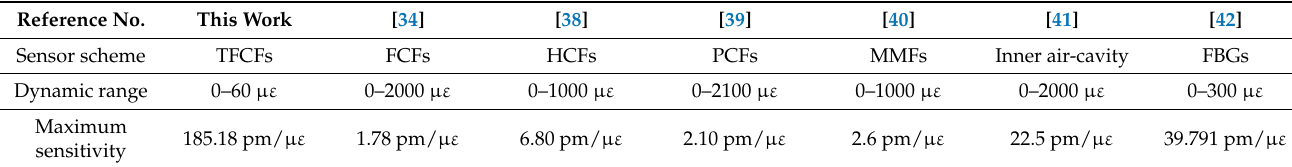
Figure 3. Spectral responses of the TFCF interferometer under different tensile strain for ( a ) D = 15 µ m, ( c ) D = 7.5 µ m, and ( e ) D = 3 µ m, respectively. Linear fitting curves of the dip wave- length shifts and the coefficients of determination R 2 of linear fitting for ( b ) D = 15 µ m, ( d ) D = 7.5 µ m, and ( f ) D = 3 µ m, respectively. Table 1. Summary of strain sensors using different